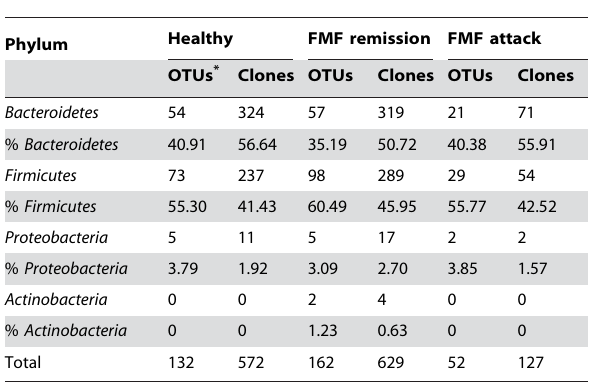
Table 1. MEFV genotypes of FMF patients and control subjects and gut microbiota analysis methods applied.